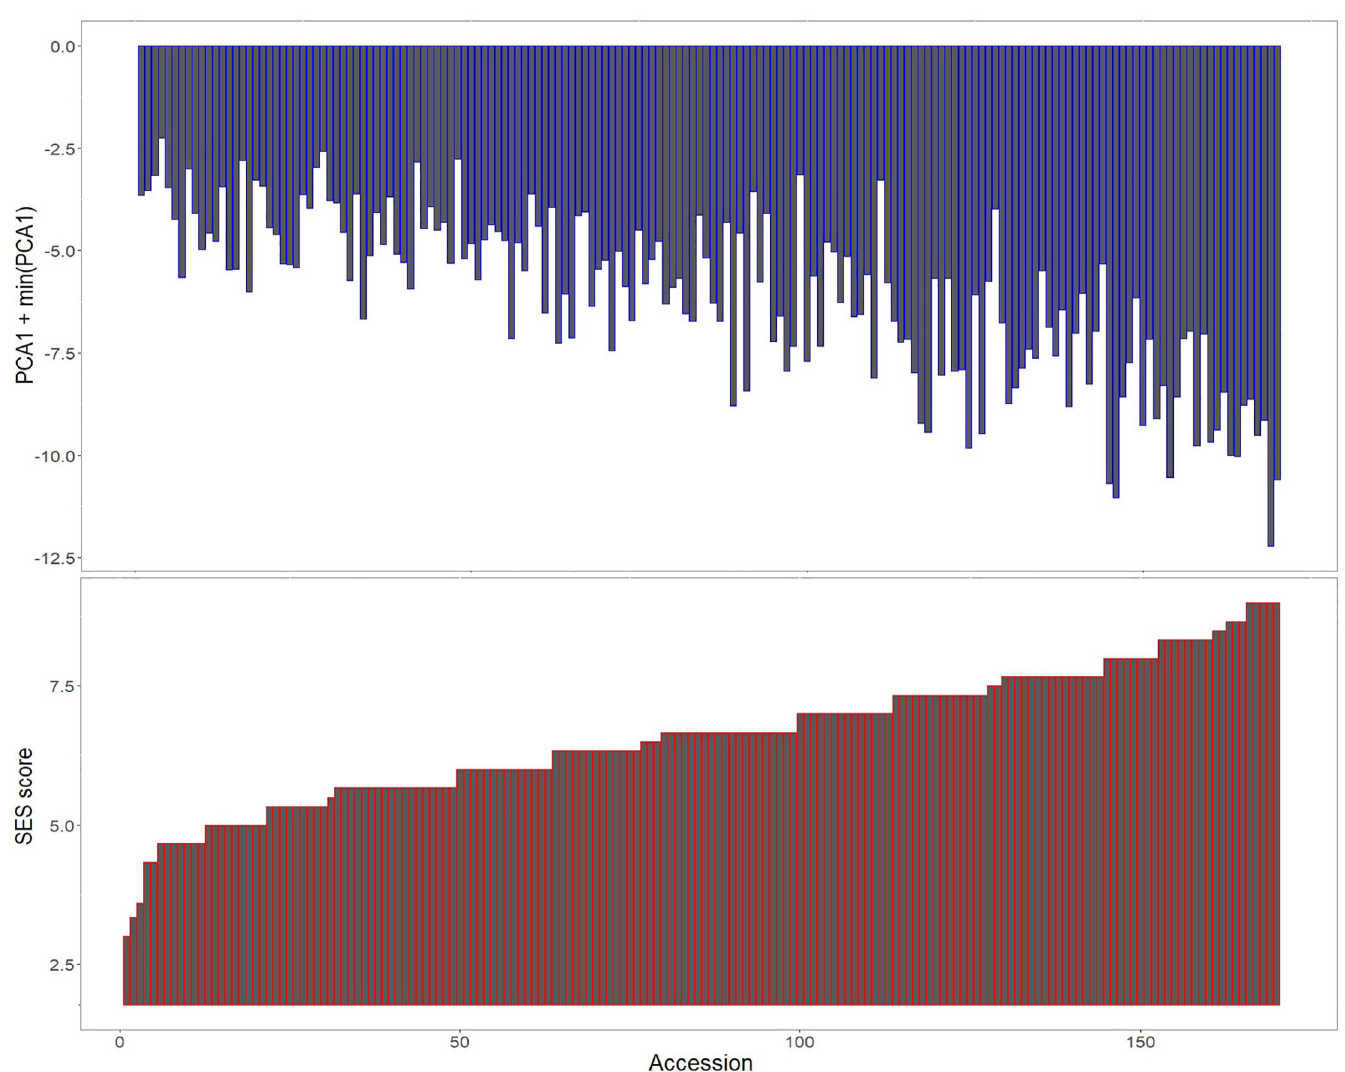
Fig 4. Complementarity between SES scores and principal component 1 derived from biomass and chlorophyll content in stress conditions. The principal component along the axis of maximum variation could explain 69.6% of the total variation. Metrics derived from simple numerical phenotypes could substitute for SES scores when a more objective index of salt injury is